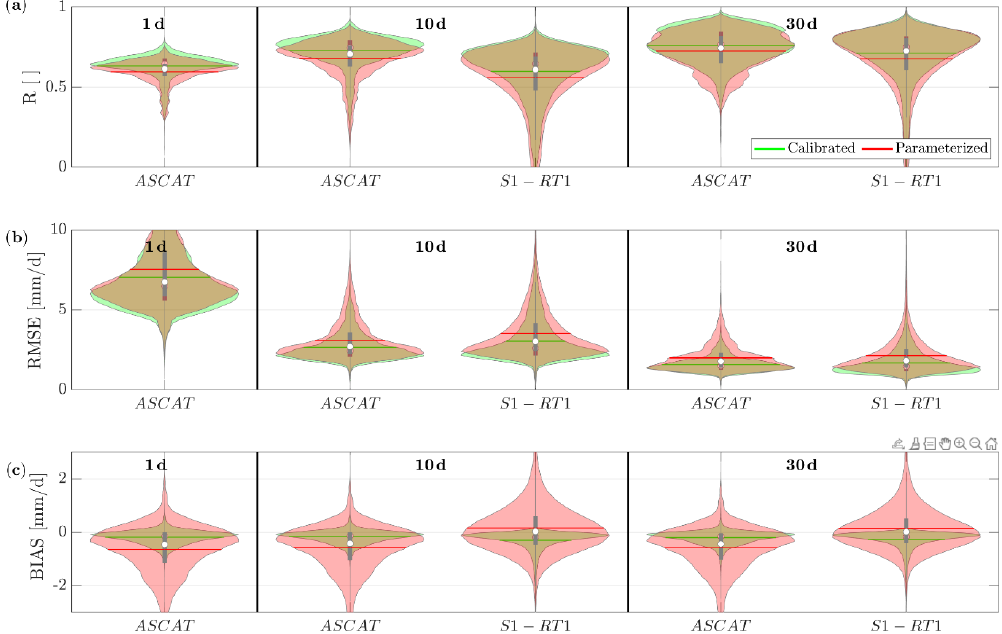
Figure 3. Violin plots of Pearson’s correlation ( R , a ), root mean square error (RMSE, b ) and bias (c) between the rainfall from MCM and from SM2RAIN applied to ASCAT and S1-RT1. ASCAT-derived rainfall was accumulated at 1, 10 and 30d, while the rainfall from S1-RT1 was accumulated at 10 and 30d. Each violin shape is obtained by rotating a smoothed kernel density estimator. The green violins are obtained by calibrating SM2RAIN against MCM, while the red violins are derived from the parameterized SM2RAIN procedure.